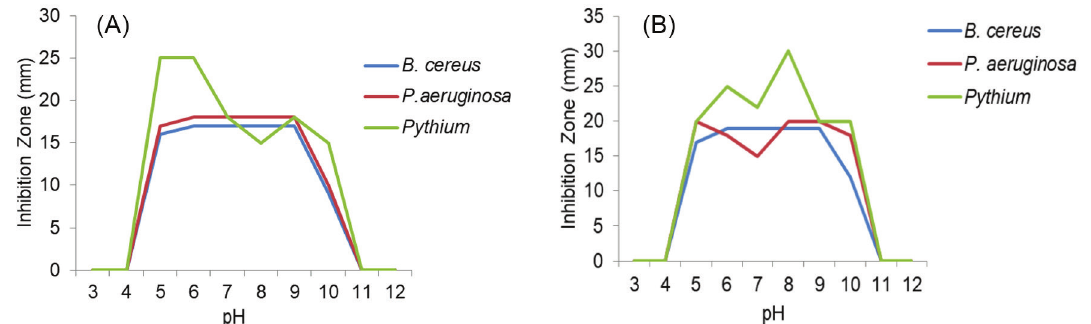
FIGURE 6 - The effect of pH on the antimicrobial activity of B. amyloliquefaciens DSM7 and B. subtilis subsp. subtilis str. 168 against B. cereus , P. aeruginosa , and Pythium (A) B. amyloliquefaciens DSM7 (B) B. subtilis subsp. subtilis str. 168.